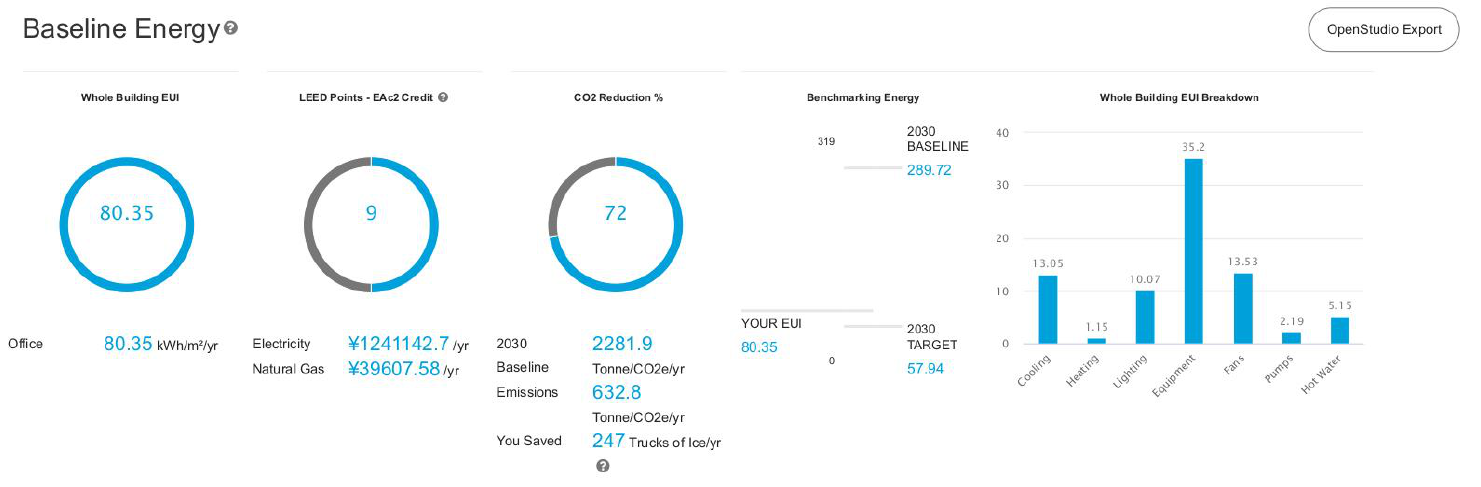
Figure A6. Zone 2-A Guangzhou, Guangdong (post-COVID-19 84% scenario).